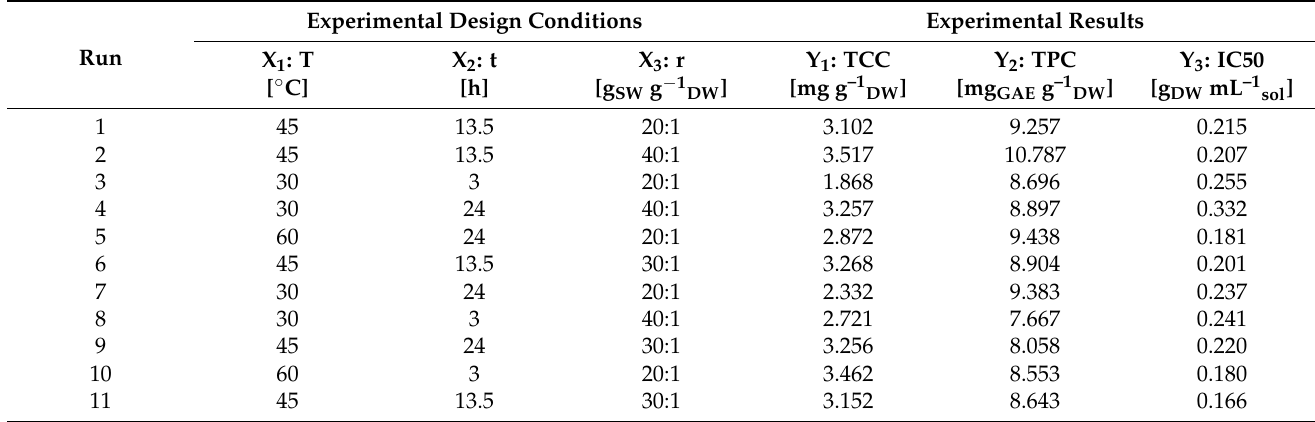
Table 3. Experimental results of C. vulgaris extraction with DES1/w regarding TCC, TPC, and IC50. Experimental Design Run